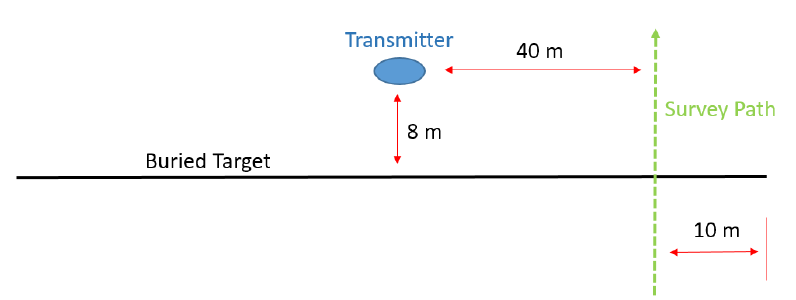
Figure 10. Geometry used for single (Figure 8) and gradient (Figure 9) signal